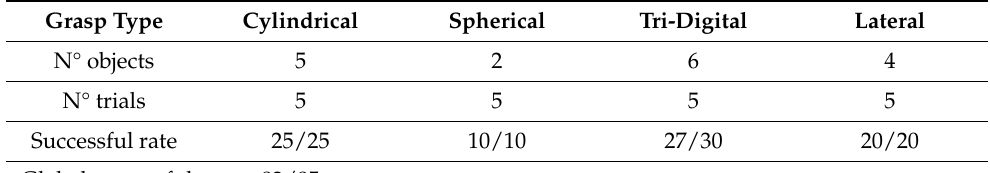
Table 3. Results about different tasks